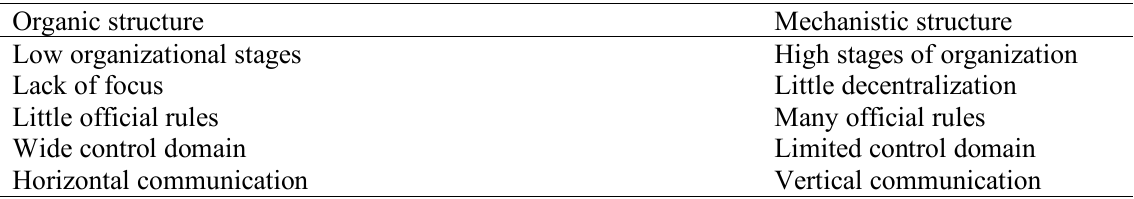
Table 1 . Comparison of Organic and Mechanistic Organizational Structure